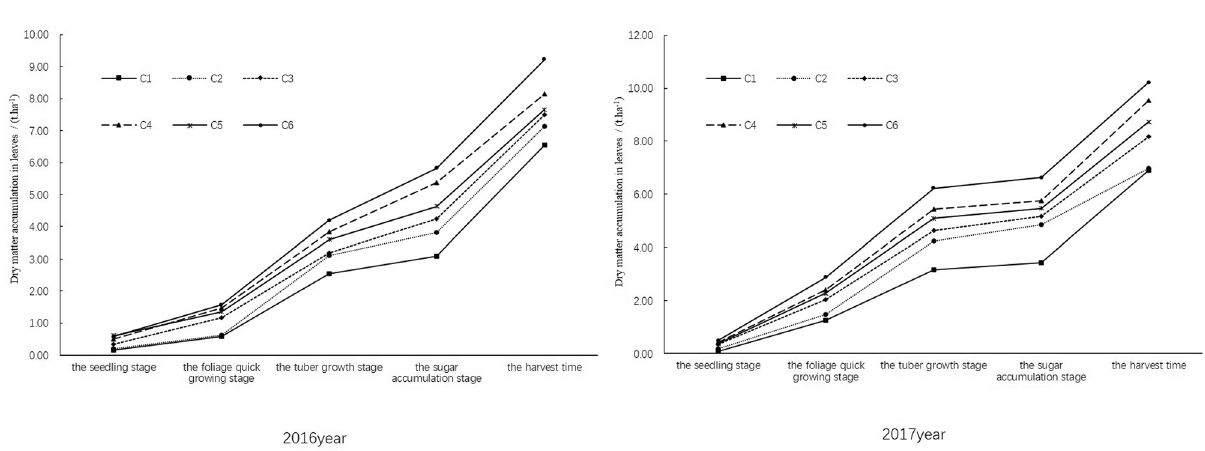
Figure 3. Effect of limited irrigation on dry matter accumulation in the roots of sugar beet in 2016 and 2017.